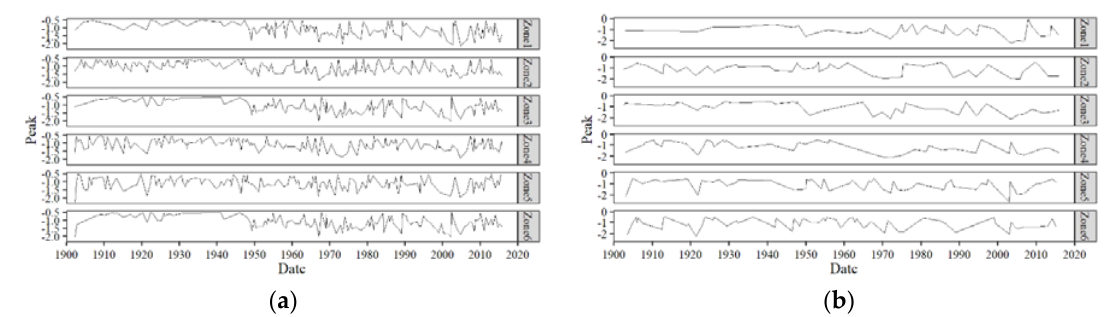
Figure 13. ( a ) 3-month and ( b ) 12-month intensity of droughts. Figure 13. ( a ) 3 ‐ month and ( b ) 12 ‐ month intensity of droughts. Figure 13. ( a ) 3 ‐ month and ( b ) 12 ‐ month intensity of droughts.